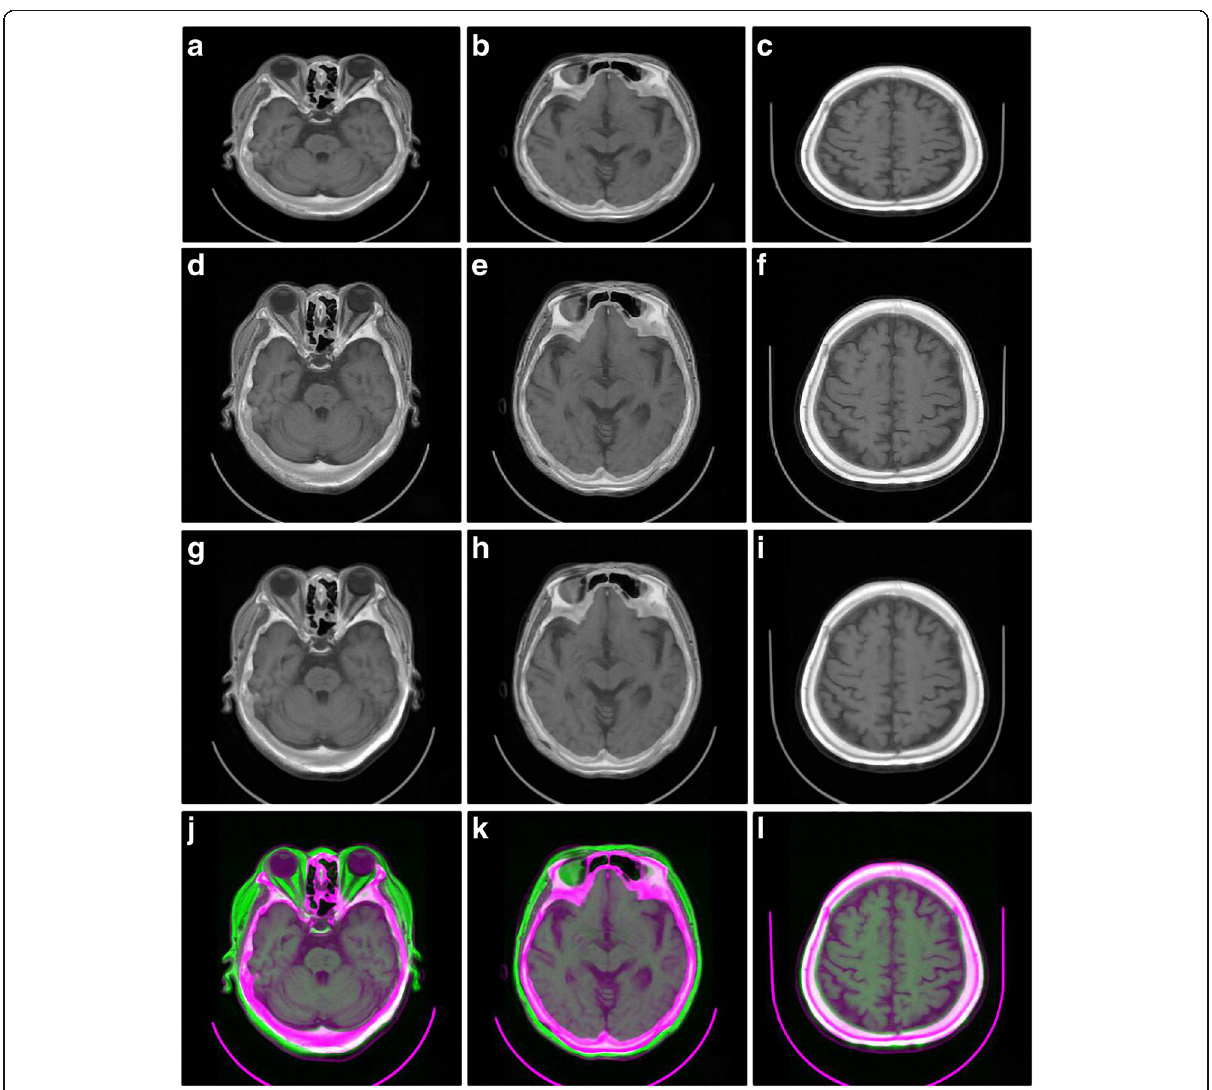
Fig. 20 The fusion image of T1-MRI and CT result of patient